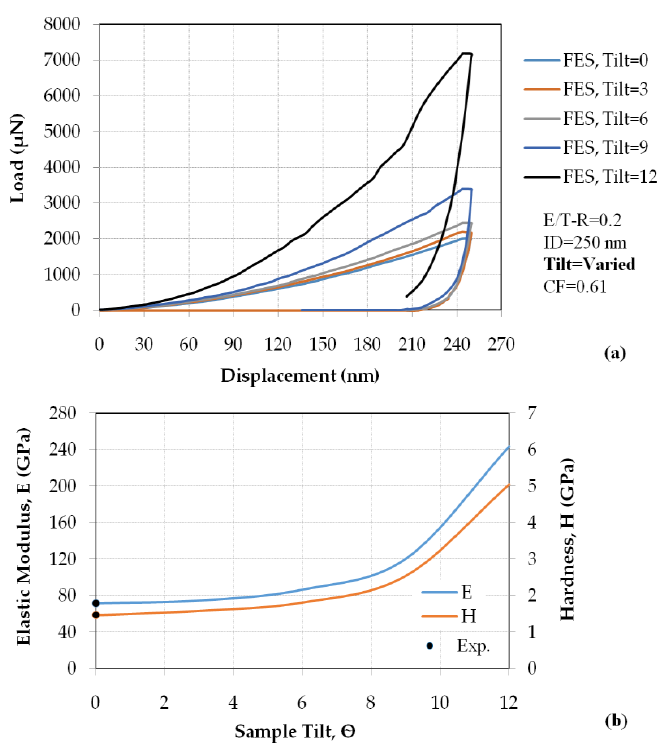
Figure 12. ( a ) Load/unload-displacement curves, and ( b ) variation of elastic modulus and hardness in the nanoindentation experiment based on different aluminum 1100 sample tilts.